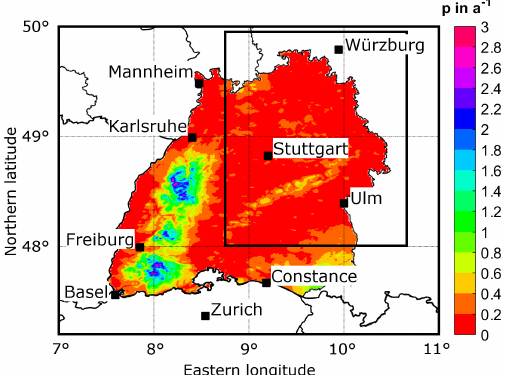
Figure 2. Probability of observed 24h rainfall totals greater than 50mm, expressed as the average days per year for Baden- Württemberg; the black box indicates the area where background precipitation R ∞ is